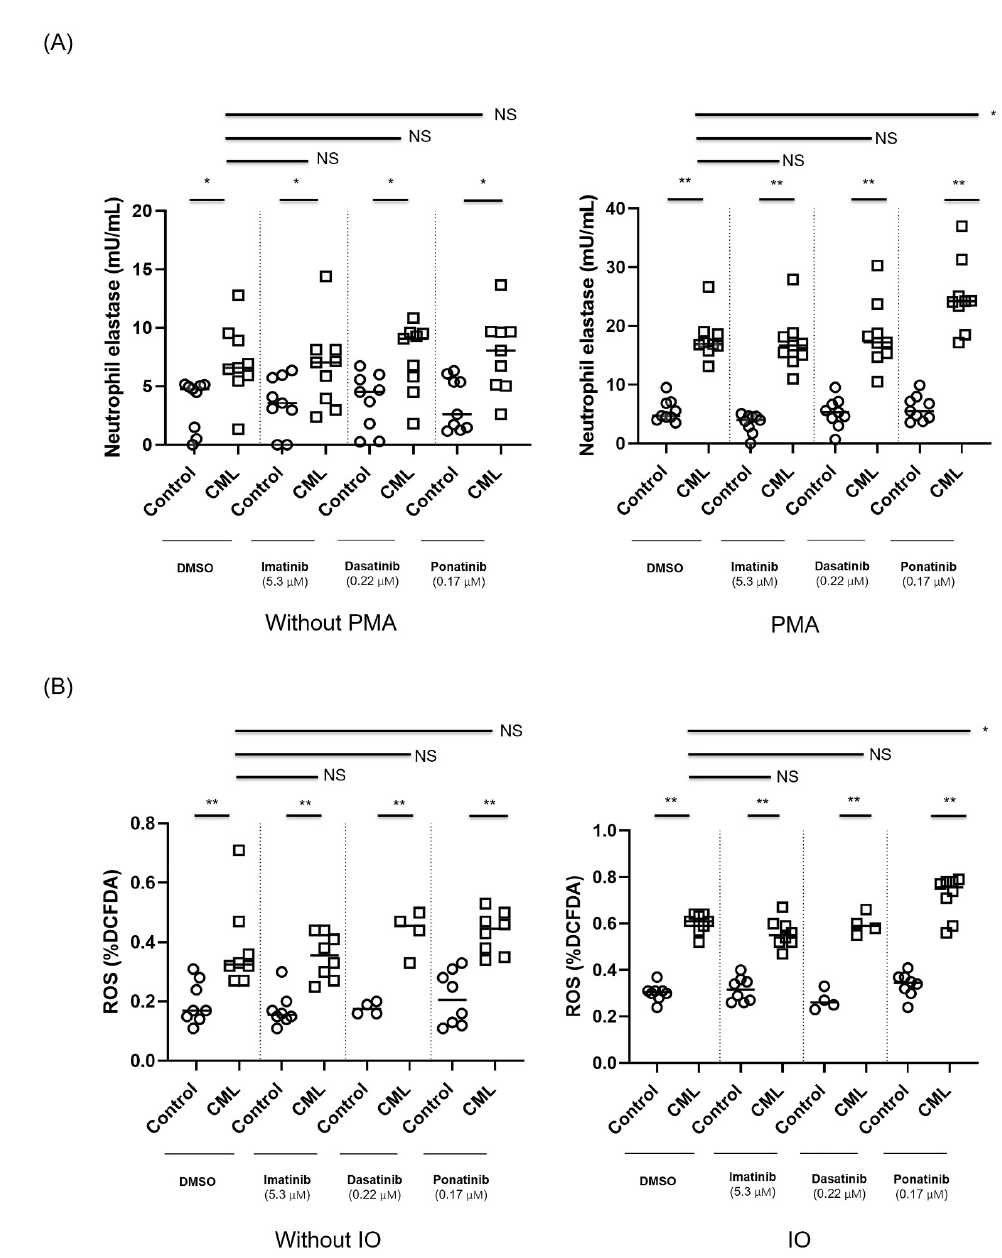
Figure 2. ( A ) Neutrophils from newly diagnosed CML patients and from age- and gender-matched controls ( n = 9 for each group) were treated ex-vivo with various tyrosine kinase inhibitors (TKIs). NET formation expressed as the amount of NET-bound elastase in patients with newly diagnosed CML compared to healthy controls when stimulated with 100 µ M PMA or DMSO for 4 h. * p < 0.05 ** p < 0.005; ns—non-significant. ( B ) ROS levels measured by DCFDA-assay in neutrophils from newly diagnosed CML patients and from age- and gender-matched healthy controls after exposure to various TKIs and stimulation with 4 µ M IO. ROS levels were measured by flow cytometry. n = 8 for control, imatinib and ponatinib; n = 4 for dasatinib. Each dot represents the mean of one patient/control triplicate. Upper bars relate to differences between CML cells treated with DMSO (control) as compared to those treated with the different TKIs. Lower bars depict the differences between control and CML cells for each condition. The following concentrations of TKIs were